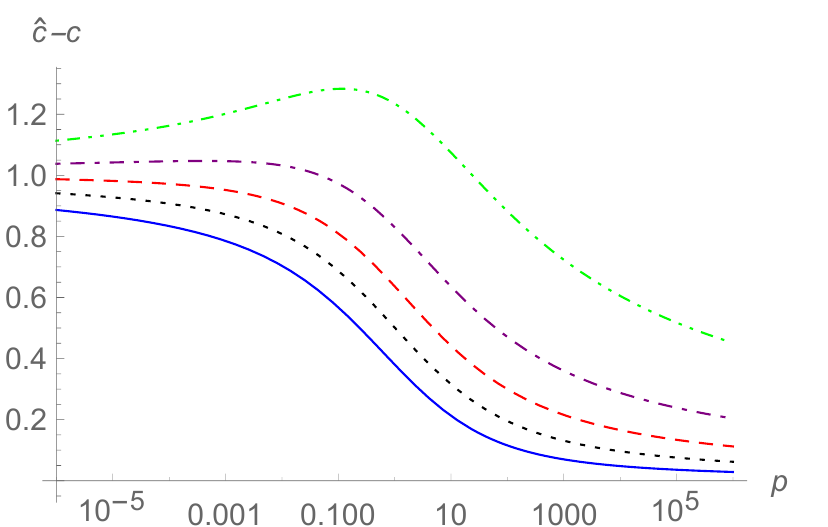
Figure 9. The damping contribution ˆ c − c versus p for η = 1 and for ω = 0.2 (solid line), 0.5 (dotted line), 1 (dashed line), 2 (dot-dashed line), and 5 (dot-dot-dashed line).